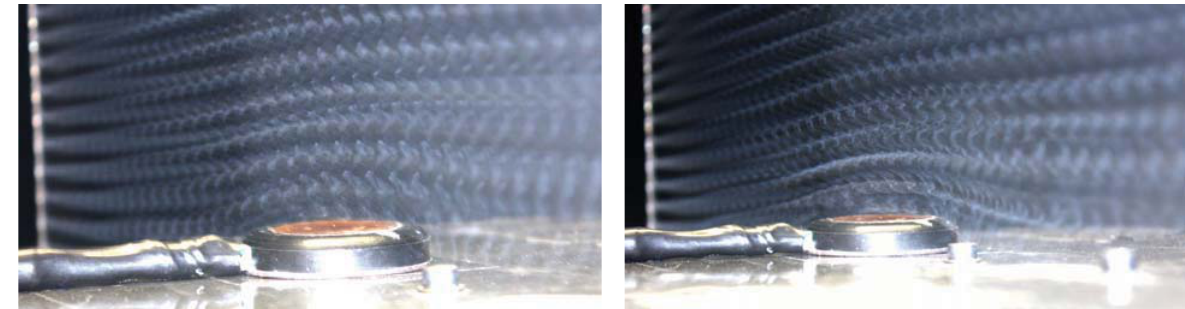
Figure 2: Flow patterns for various Re